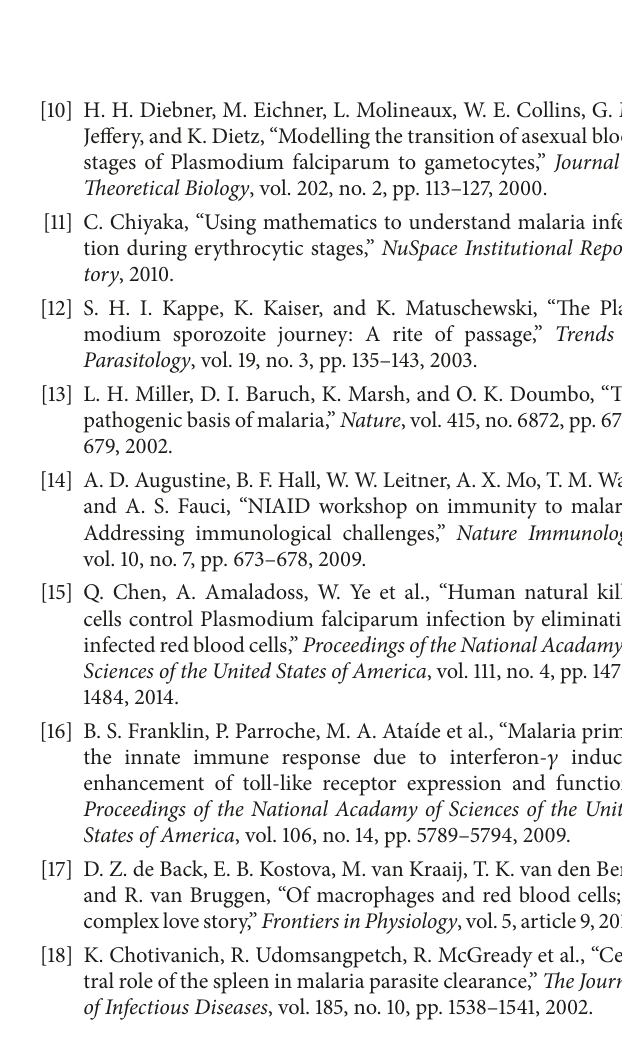
Figure 8: Graphs showing the effect of varying the rate of phagocytosis of IRBCs by macrophages, 𝜂 (in (a)), and the effect of increased decay rate of macrophages, 𝛿 𝑧 (in (b)), on the behaviour of infected erythrocytes 𝑅 𝑋 . All parameter values are in Table